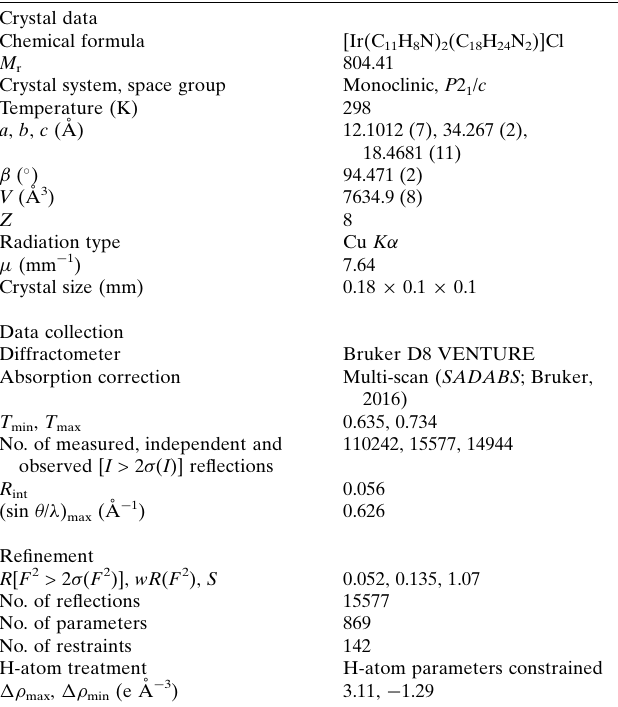
Table 2 Experimental details. Crystal data Chemical